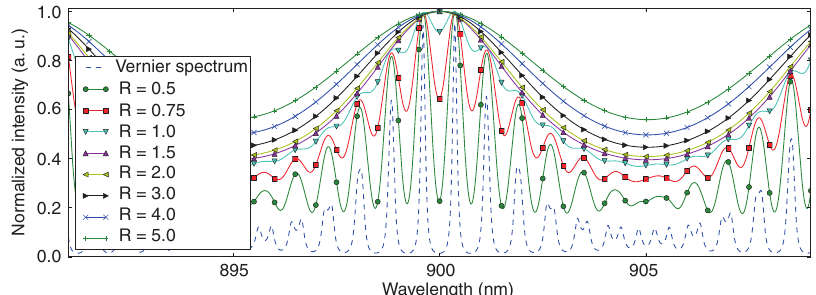
Figure 5: Convolution of Vernier spectrum with Gaussian channels of different width. R indicates the ratio of the filter channel width to the period of the constituent Vernier peaks.